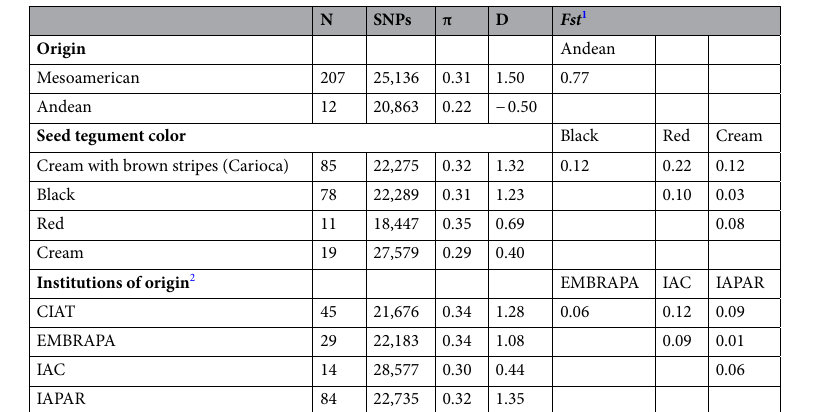
Table 2. Nucleotide diversity (π), Tajima’s D and weighted Fst estimated in the Brazilian common bean diversity panel in relation to different centers of origin, seed colors, and institutions of origin. N number of accessions, SNPs number of SNPs, π nucleotide diversity, D Tajima’s D statistics. 1 Weir and